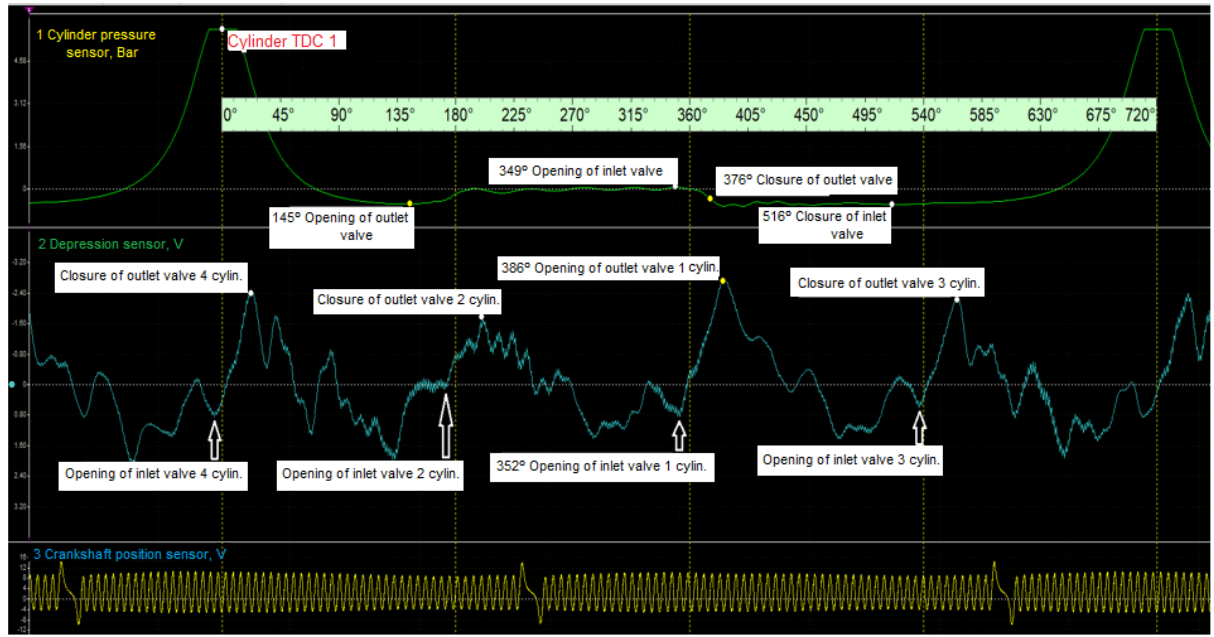
Figure 2. An oscillogram of the pressure sensor (channel 1), the depression sensor (channel 2), the crankshaft position sensor (channel 3)